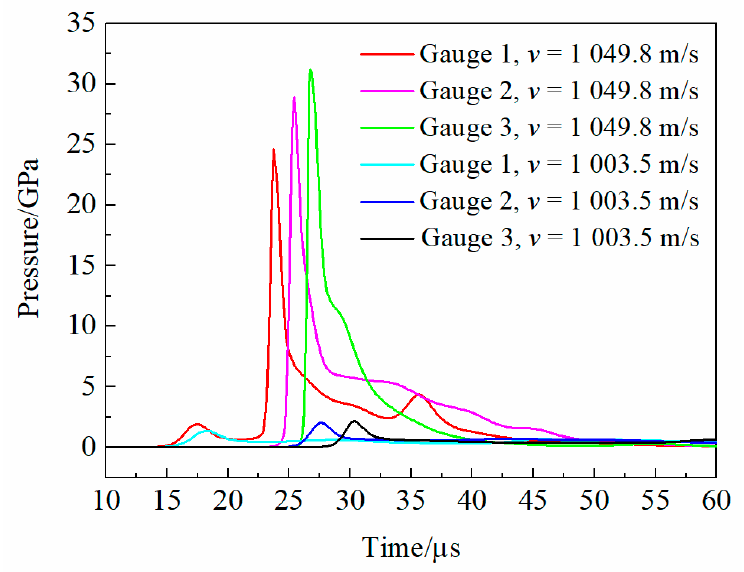
Figure 4. The pressure curves of the three gauges of the numerical model when the v ’s are 1003.5 m/s and 1049.8 m/s, respectively.